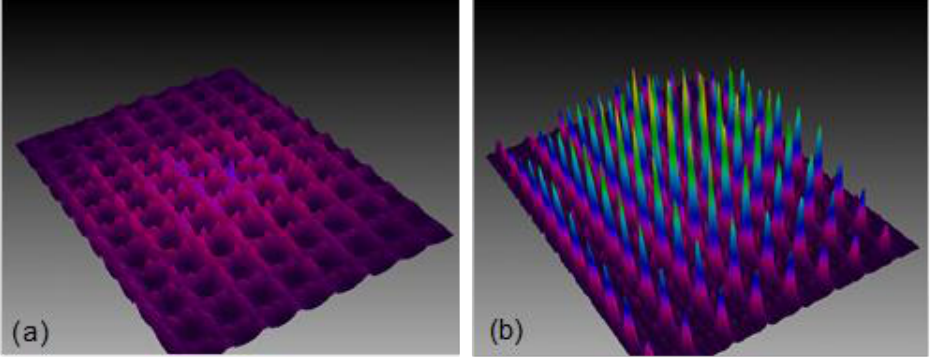
Figure 12. Measured 3D light intensity distribution: ( a ) V = 0 and ( b ) V = 65 V. The figures were reorganized from ref. [53] with permission.